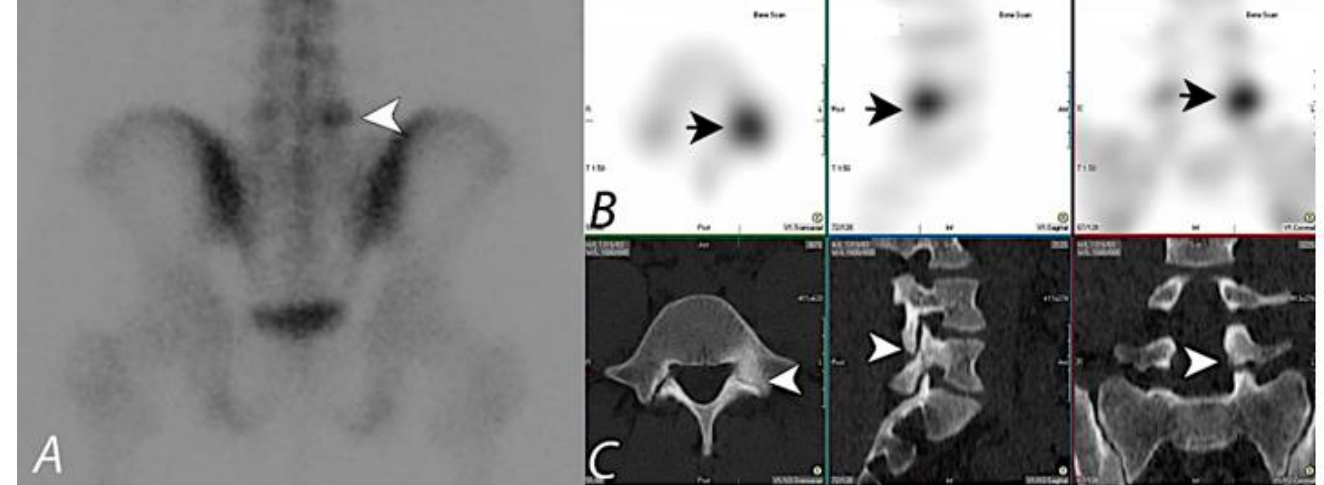
Figure 1. 99m Tc MDP bone scan planar (spot) view image ( A ) of pelvis on a young patient presenting with chronic left sided low back pain, showing focal uptake (black arrowhead) in the lower lumbar region on the left side. SPECT images in axial, sagittal, and coronal planes ( B ) localizes the activity to posterior aspect of L5 vertebral body on the left side (Short black arrows). Correlative CT images in axial, sagittal, and coronal planes ( C ) demonstrate a bony defect in the isthmus of the left L5 level pars intraarticularis (white arrowheads), consistent with a monolateral spondylolysis. Taking into consideration the pars defect on anatomic imaging at this level and the focal activity on the bone scan, it can be assumed that the activity most likely correlates with the anatomic abnormality. Lack of co-registration of anatomic and functional information on this set of images prevents definitive interpretation, and hybrid SPECT/CT with fused information can significantly improve diagnostic confidence.